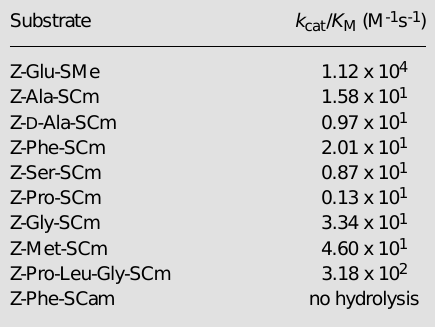
Table 3 - Kinetic constants for V8 protease-cata- lyzed hydrolysis of carboxymethyl thioester sub- strate mimetics compared to the normal-type sub- strate Z-Glu-SMe (32).